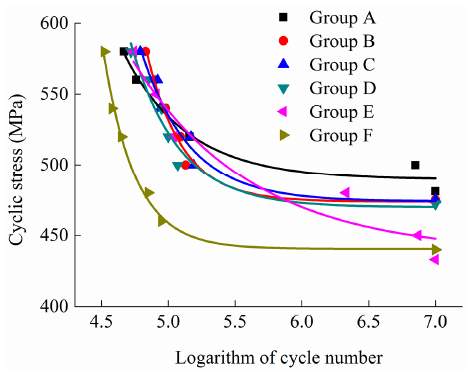
Figure 11. Cyclic stress amplitude-logarithm of cycle numbers (S-lgN) curves for Ti-6Al-4V titanium alloy. Table 2. Fatigue limit and residual stress change after the VSR and annealing treatment.